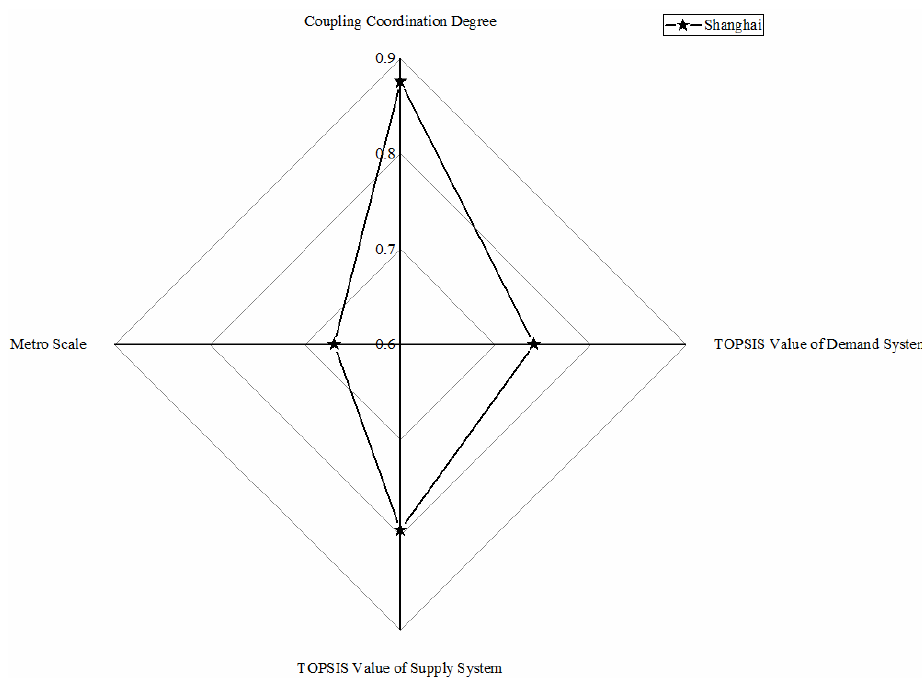
Figure 3. Metro in highly balanced with lagging demand